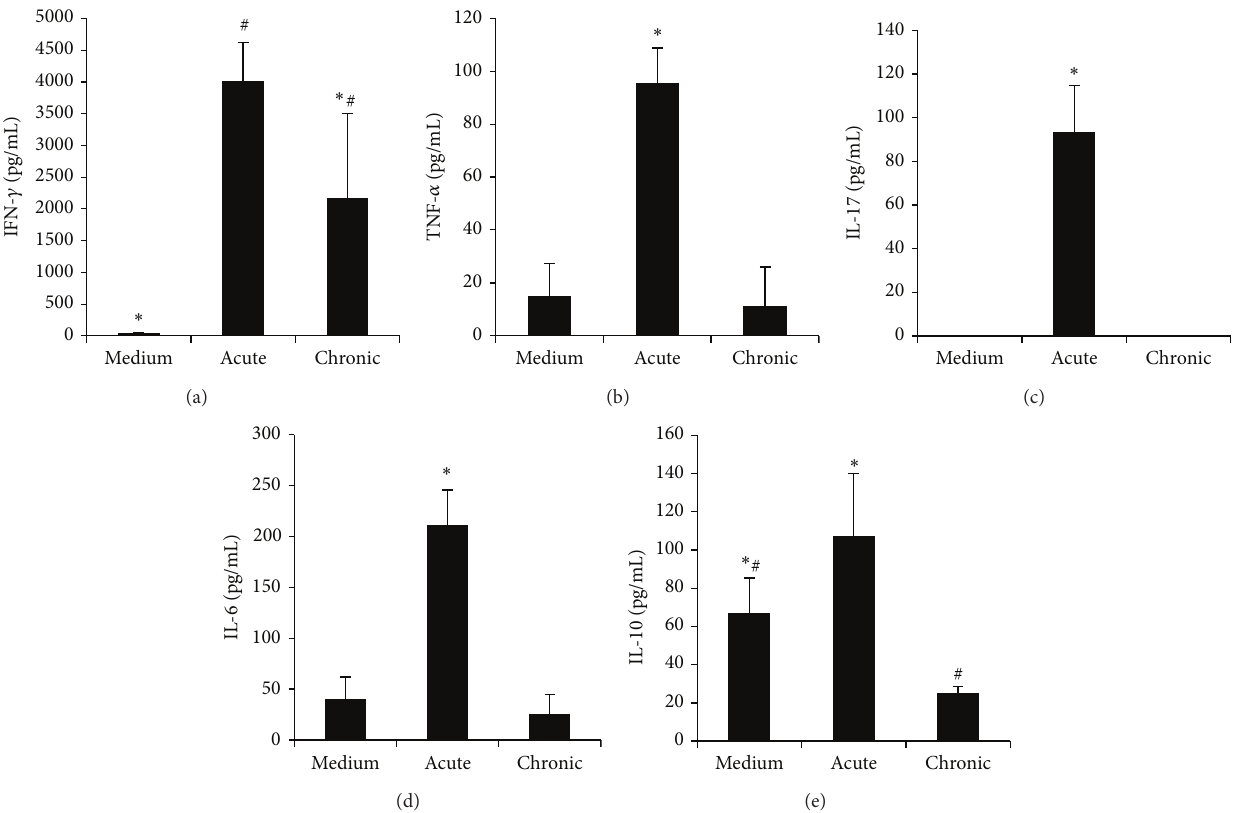
Figure 4: Production of cytokines by CNS infiltrating cells. Female C57BL/6 mice were submitted to EAE induction by immunization with MOG emulsified in CFA and the cytokine production was assayed in acute and chronic stages of EAE. IFN- 𝛾 (a), TNF- 𝛼 (b), IL-17 (c), IL-6 (d), and IL-10 (e) production by cells eluted from the brain stimulated in vitro with MOG. Data were presented by mean ± SE of 6 mice and representative of two independent experiments. ∗ and # 𝑃 < 0.05 .